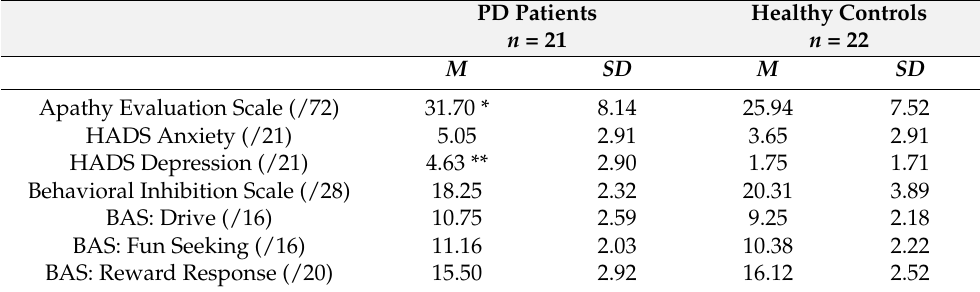
Table 4. Self-report measures for PD patients and healthy